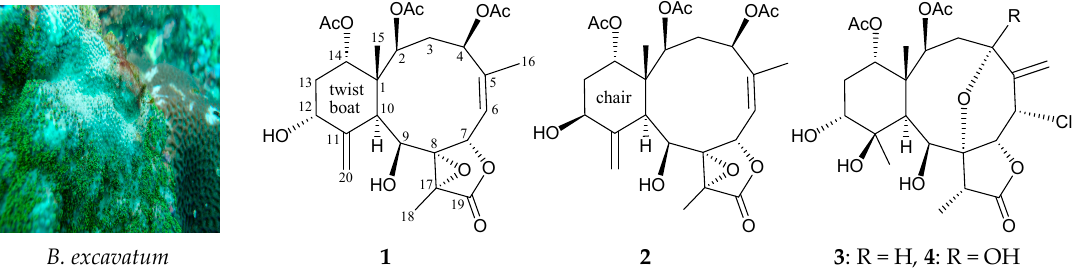
Figure 1. The octocoral Briareum excavatum and the structures of briarenols C–E ( 1 – 3 ) and briarenolide ZI ( 4